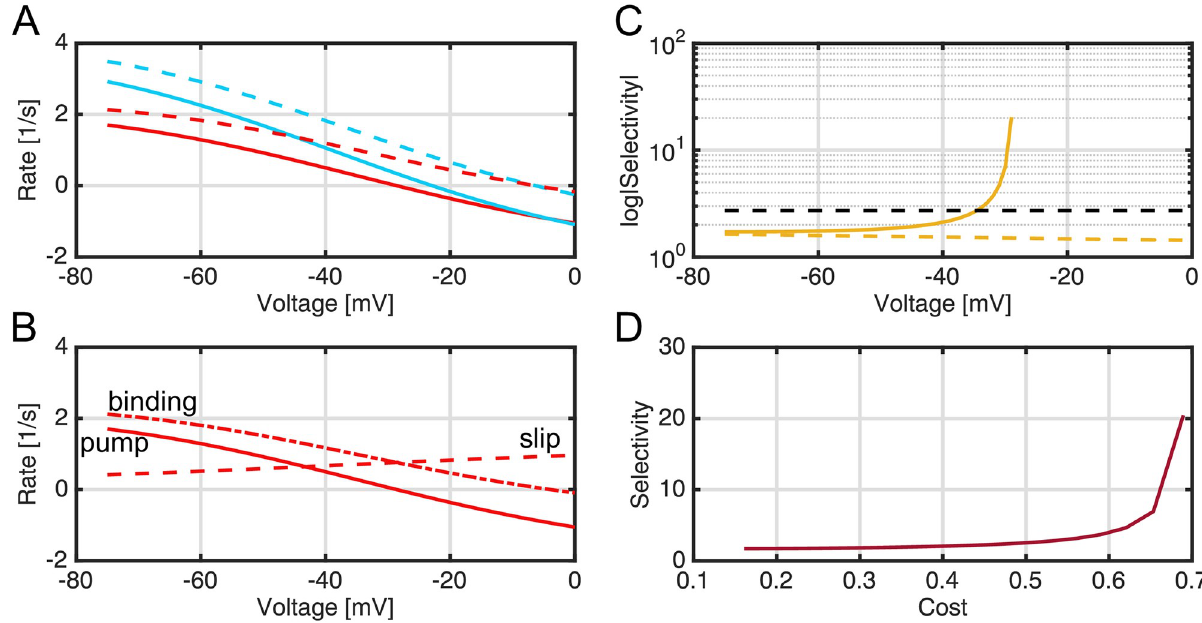
Fig 4. Flows, selectivity, and cost of a transport model with slip and weak discrimination during transport. For all calculations, the sugar binding transition to the inward state is 1 k more favorable than toxin ( DD G z ¼ 1 ), but all other parameters for sugar and toxin are identical as in S1–S3 B T 3 0 4 0 Tables. A) The flows of sugar (blue) and toxin (red) into the cytoplasm in the presence (solid curves) and absence (dashed curves) of slippage plotted as a function of membrane potential. B) Decomposition of the toxin pumping cycle. Toxin pumping into the cytoplasm, J pump , (solid curve) is equal to the W , (dot-dash curve) minus the rate of toxin escape to the extracellular space, J slip (dashed rate of binding to the outward-facing conformation, J bind W W curve) according to Eq 1. C) The selectivity ( σ ) as a function of membrane potential. Note that the ordinate (selectivity) is logarithmic. The solid gold curve is the selectivity calculated in the presence of slip (Eq 2), and the dashed gold line is the selectivity observed when slip is disabled. The dashed black line is the theoretical selectivity estimate based on a discrimination of 1 k B T at the inward-transition step. D) The selectivity ( σ ) is plotted versus cost ( C , see Eqs